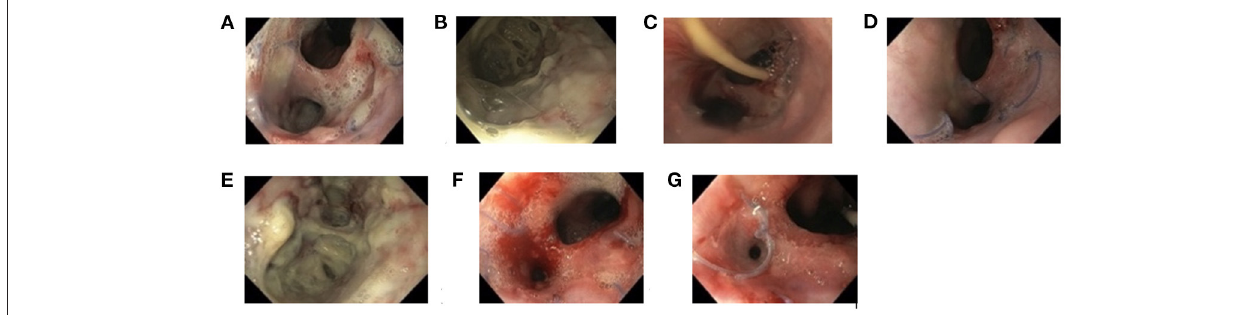
FIGURE 1 | Documentation of endoscopic findings during endoscopic esophageal vacuum-assisted closure (EVAC) and Replogle Suction Catheter (RSC) therapy (Patient 4). First impression of anastomotic insufficiency forming a second lumina into the mediastinum (A) , shown more closely (B) . Esophageal perforation after 4 days (C) , 8 days (D) , and 12 days (E) of EVAC therapy. After day 8, EVAC was replaced by an RSC (F) . Fully healed esophageal perforation 10 days after RSC (G) .